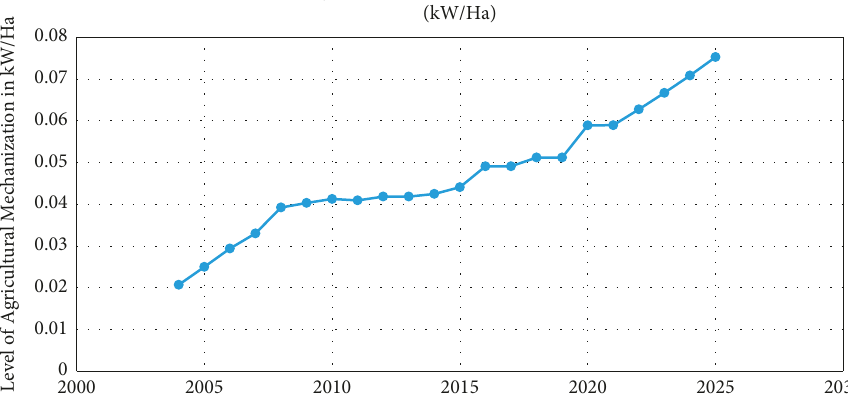
Figure 1: Level of agricultural mechanization from 2004 to 2025 in kilowatts per